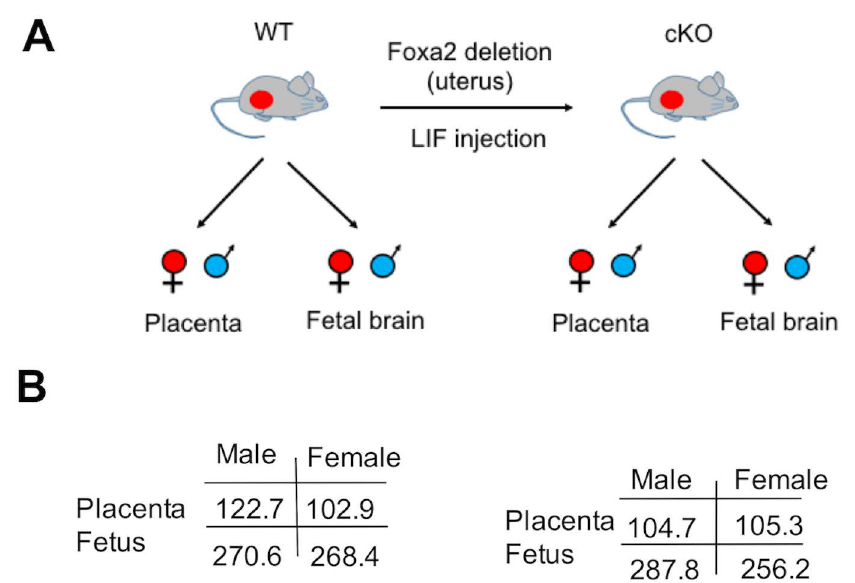
Figure 1. Overview of the study. ( A ) Experimental design. The WT and Foxa2 cKO pregnant mice (red dot indicating pregnant) were dissected to collect fetal brain and placenta samples of both sexes. ( B ) Comparison of fetal and placental weight. M: male and F: female. Weights, in milligram, of the fetus and placenta of the WT ( left ) and cKO mice ( right ). Sample size: n =